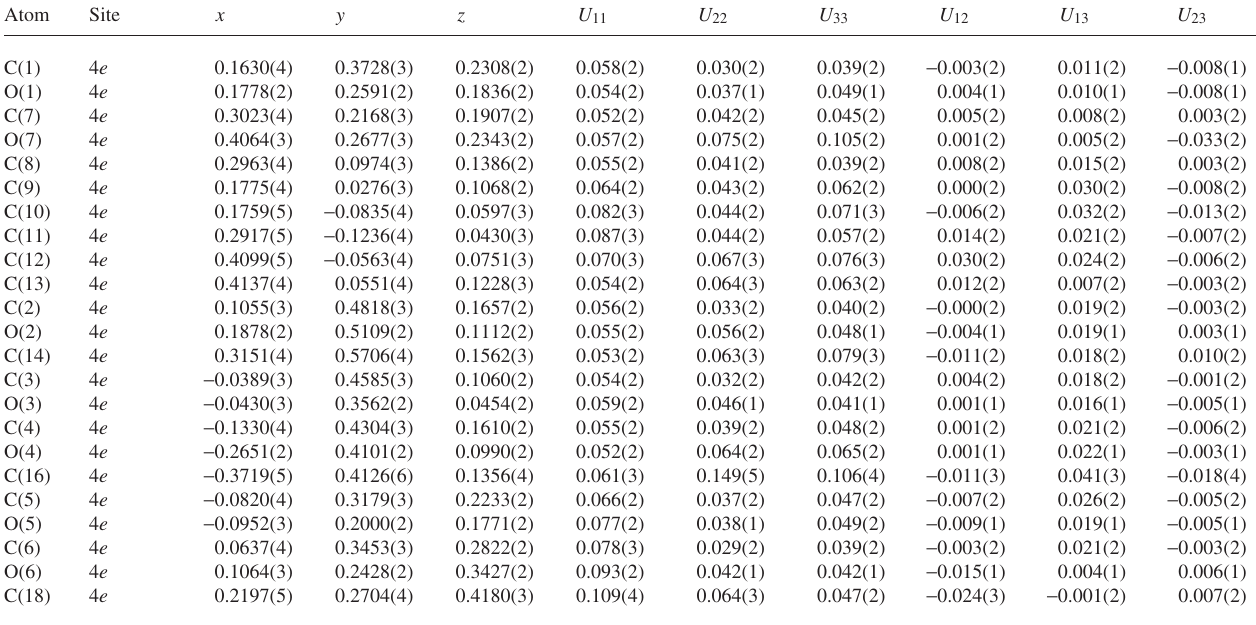
Table 3. Atomic coordinates and displacement parameters (in Å 2 )